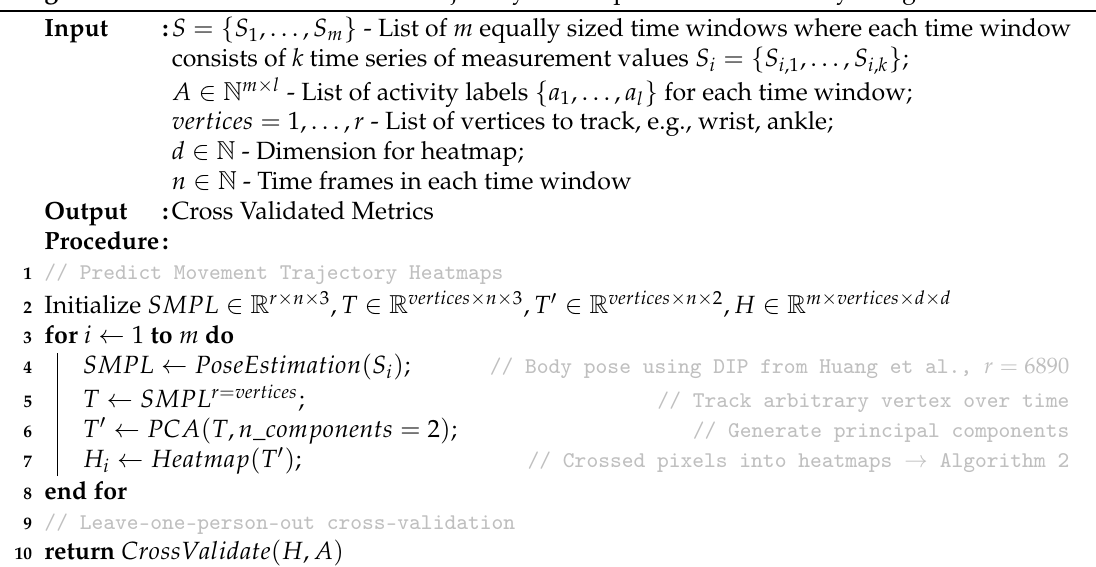
Algorithm 1: IMU-based movement trajectory heatmaps for human activity recognition.